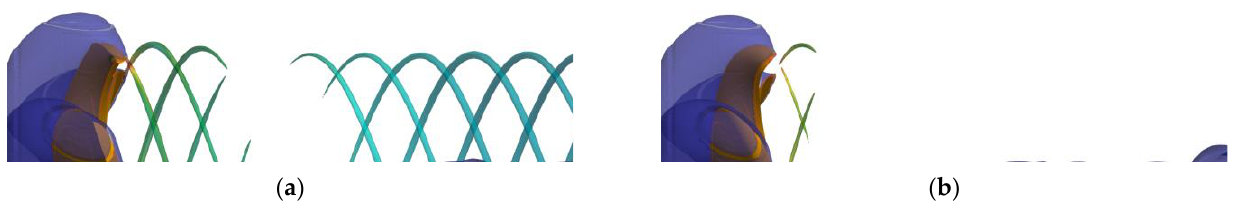
Figure 8. Instantaneous (22nd propeller revolution) isosurface of the pressure coefficient ( − C PN ) colored with the magnitude of vorticity scaled by U inf /D . Details at tip for − C PN = 0.1. Advance coefficient J equal to 0.9. ( a ) Conventional CLT; ( b ) New generation CLT.